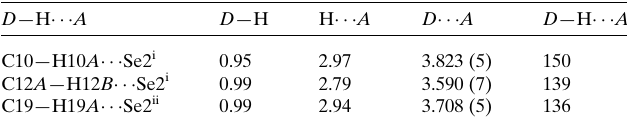
Table 1 Hydrogen-bond geometry (A˚ , (cid:4) ).